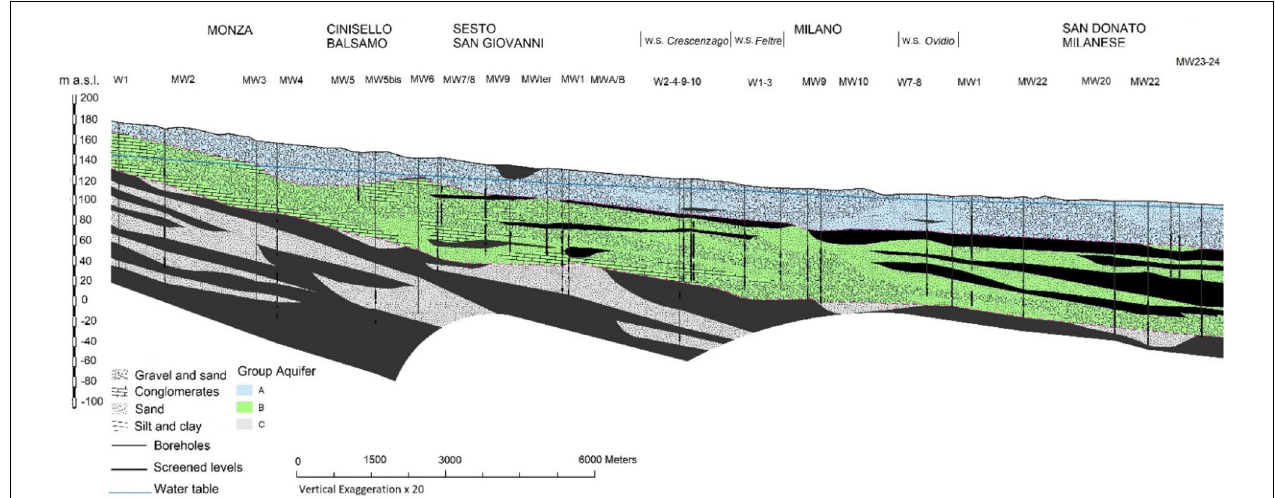
FIGURE 3 | North-South cross section AA’ corresponding to the blue line in Figure 1 . Aquifers A and B are in light blue and